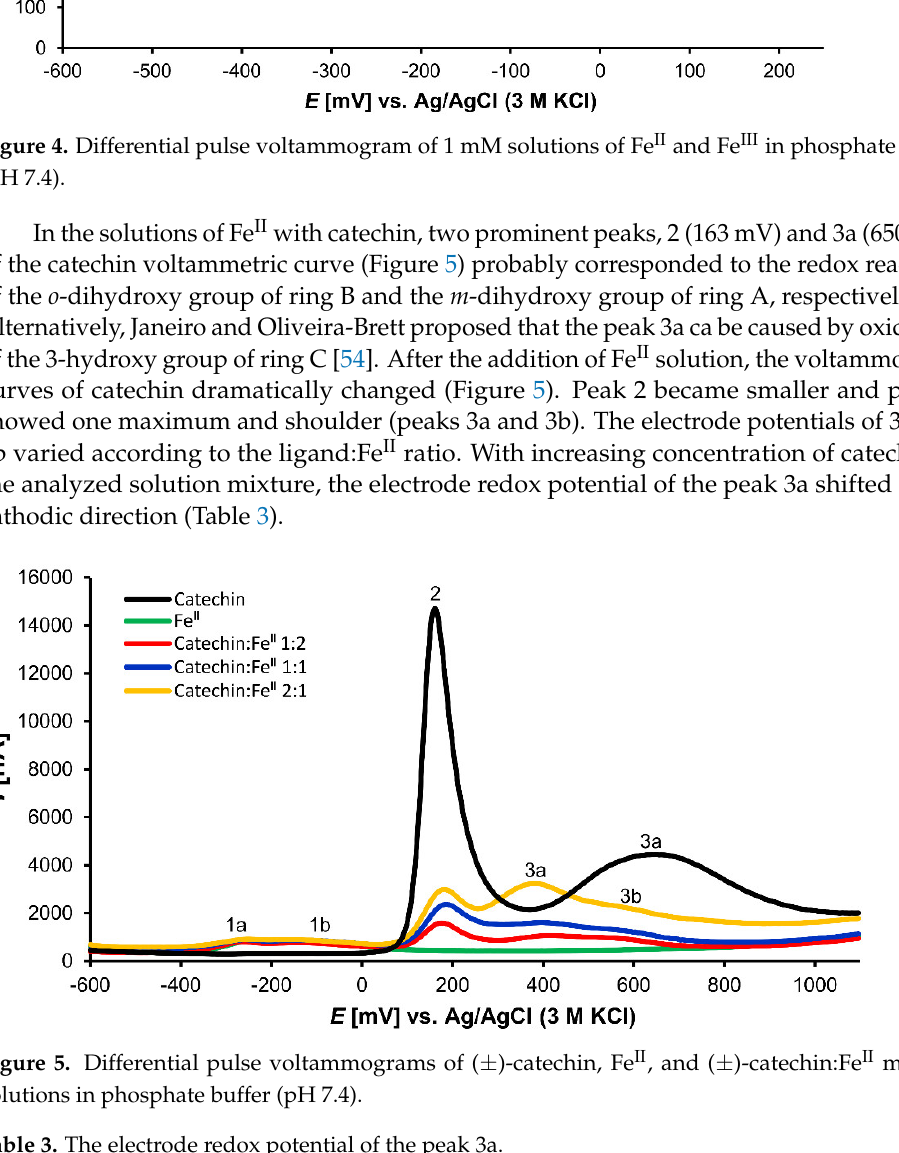
Table 3. The electrode redox potential of the peak 3a.